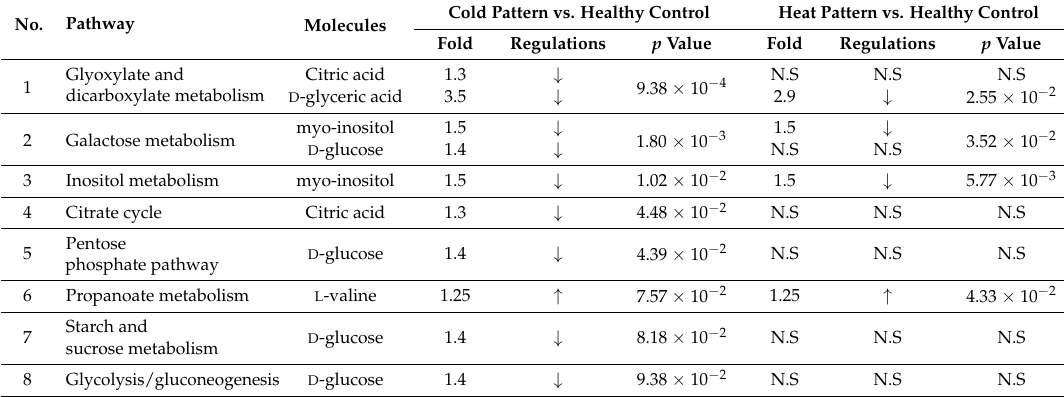
Table 2. Comparison of cold pattern vs. healthy control and heat pattern vs. healthy control in carbohydrates metabolism ( ↑ , upregulation, ↓ , downregulation, N.S, no significance). No. Pathway